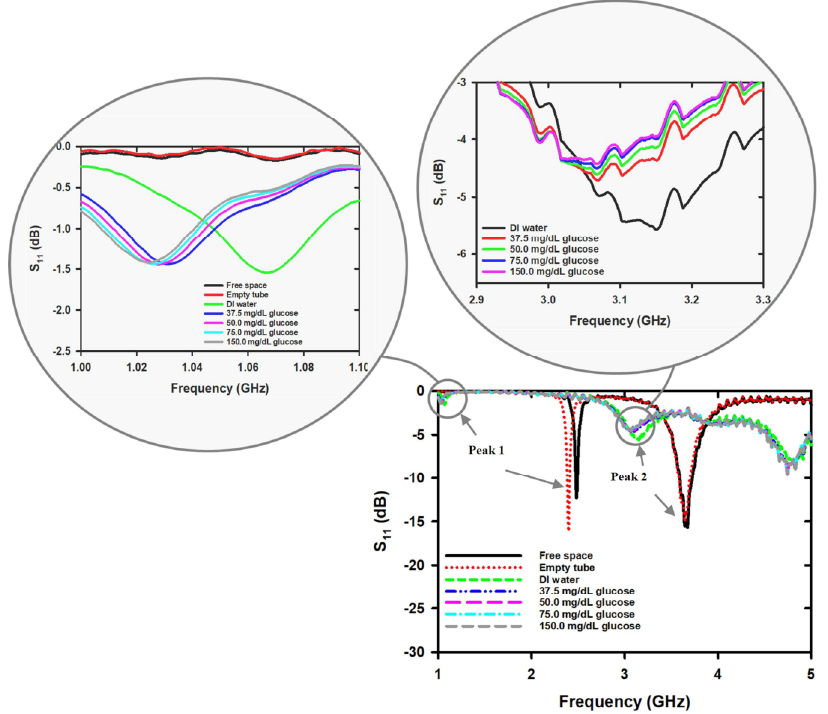
Figure 5. The reflection coefficients of the microwave sensor were measured for free space, an empty tube, DI water, and glucose concentrations of 37.5, 50, 75, and 150 mg/dL in the solution. The aachment of the chamber tube to the sensor leads to a slight alteration in the magnitude and resonance frequency of peaks 1 and 2, as shown by the measurement re- sults. The magnitude of S 11 at peak 1 (2.48 GHz and 2.40 GHz) was −12.30 dB in free space and −16.10 dB in the empty tube test, indicating a difference of −3.80 dB or 30.89%. Addi-